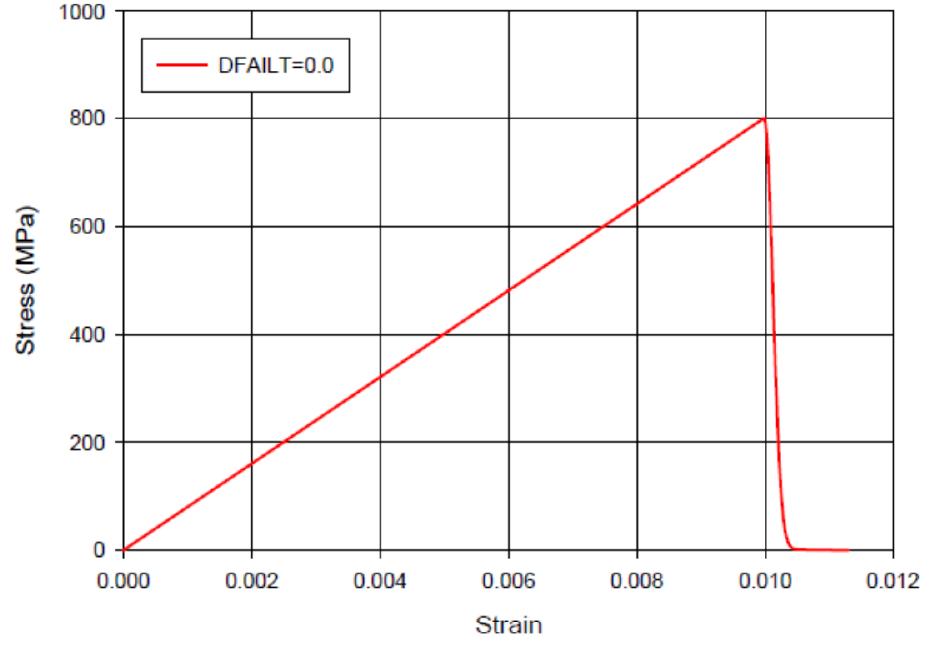
Figure 2. Stress – strain curve in fibre direction under tension, DFAILT = 0.0 [51]. Figure 2. Stress–strain curve in fibre direction under tension, DFAILT = 0.0